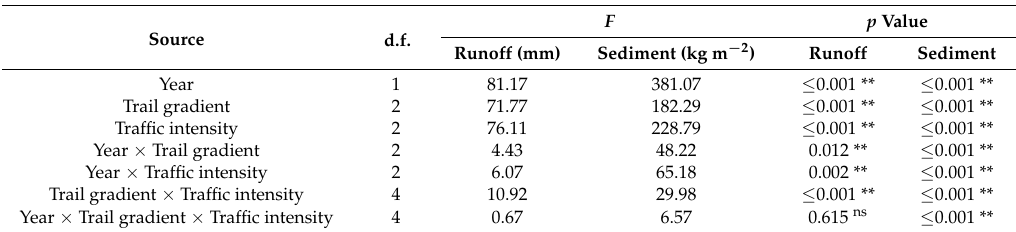
Table 2. ANOVA for the effect of trail gradient, traffic intensity, and year, and their interaction on runoff and sediment.